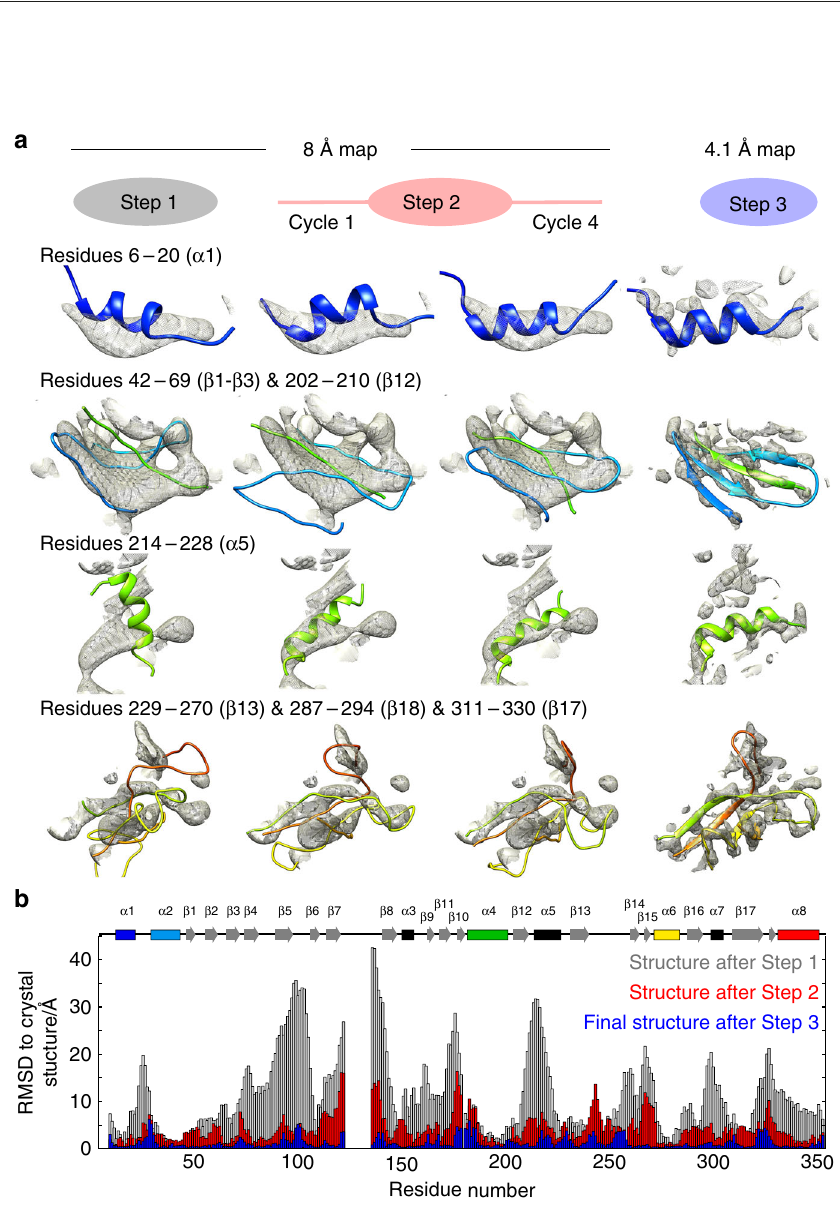
Fig. 3 Structure re fi nement from NMR and EM data. a Zoom onto selected parts of the TET2 structure along the different steps of the structure determination process. The 3D EM map used at 8 Å resolution (steps 1 and 2) and 4.1 Å resolution (step 3) is shown as a gray surface. The structures shown correspond to the lowest-energy models generated by CYANA (steps 1 and 2) or XPLOR-NIH (step 3). A comprehensive view of the evolution of all structure elements is provided in Supplementary Fig. 11. b Residue-wise heavy-atom backbone RMSD relative to the crystal structure throughout different steps of the structure determination